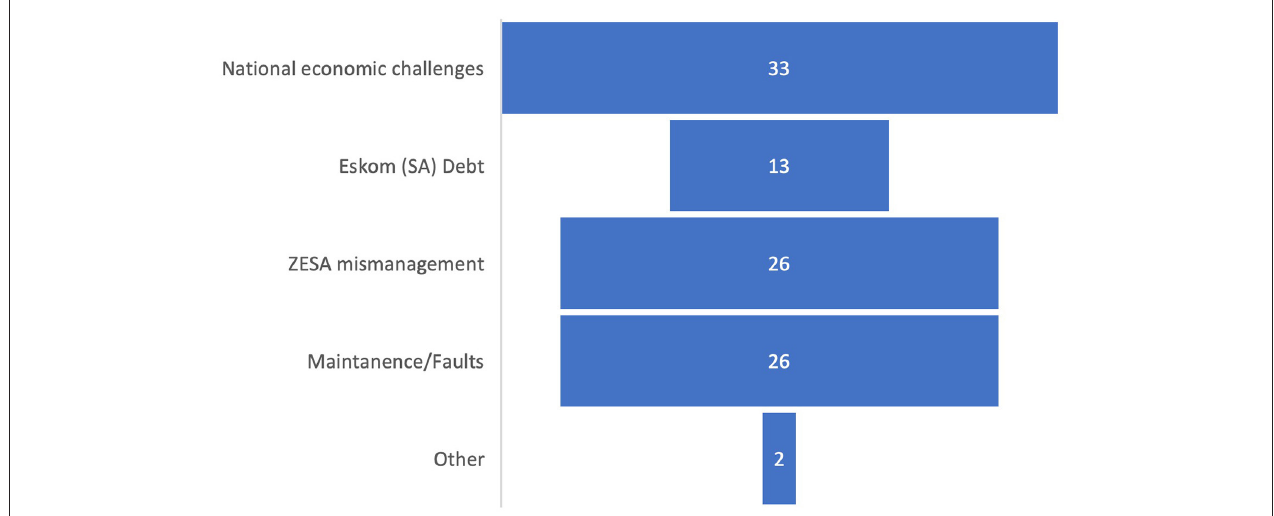
FIGURE 9 | Reasons behind load shedding in percentages. Source: Field survey